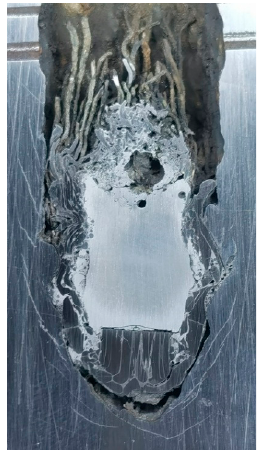
Figure 8. Bending and backflow fracture mode of tungsten fibers during penetration of WF/Zr-MG rod [20].